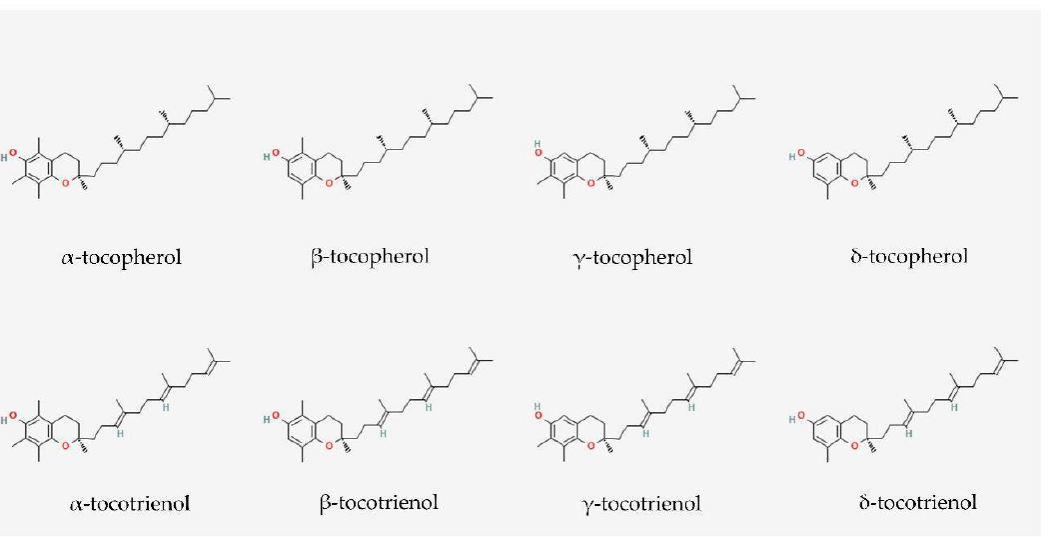
Figure 2. Molecular structures of tocopherols and tocotrienols. They consist of a chromanol ring and a long carbon tail. Tocopherols and tocotrienols have saturated and unsaturated carbon tails, respectively. Each isomer is distinct from each other by the position of the methyl side chain on the chromanol ring. The structures were obtained from PubChem.